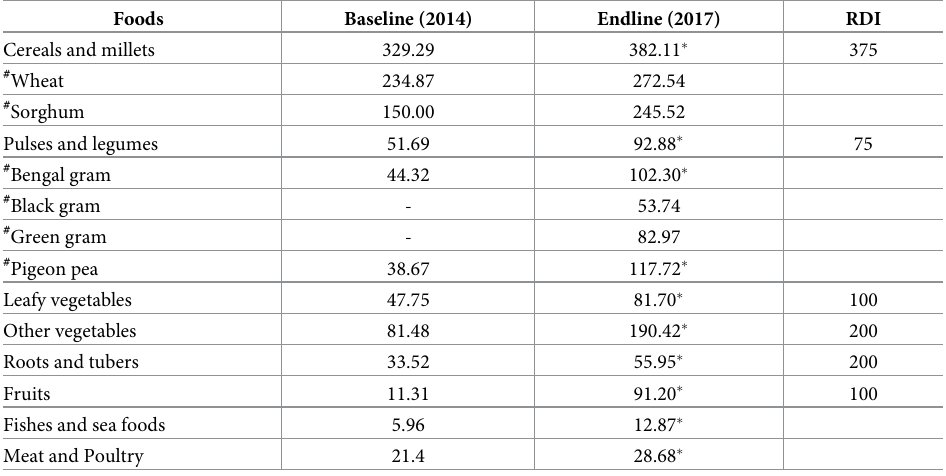
Table 6. Average intake (g/CU/day) of different food groups against recommended dietary intake (RDI) between Baseline (2014) and Endline (2017) in Wardha (N = 158).